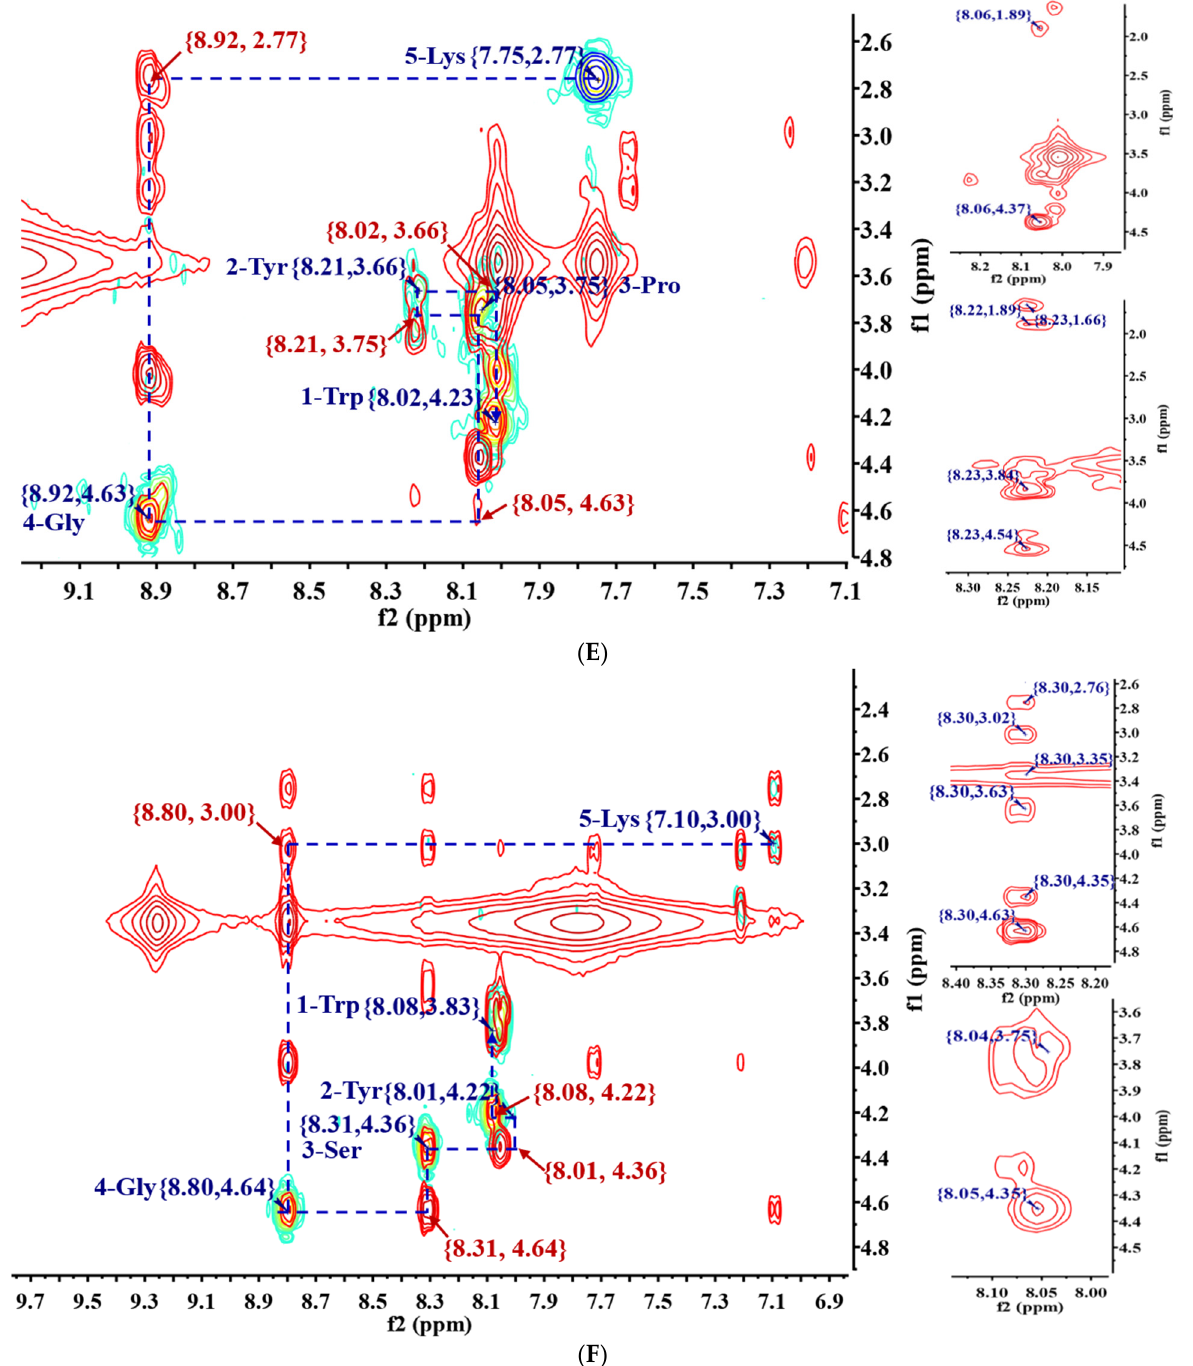
Figure 3. CD and NMR spectroscopy analysis of WYPGK and WYSGK. ( A ) CD spectra; ( B ) secondary structure analysis; the 1H NMR spectroscopy of ( C ) WYPGK and ( D ) WYSGK; COSY-NOESY NMR fingerprinting of ( E ) WYPGK and ( F ) WYSGK. ** indicates statistically significant differences ( p < 0.01).